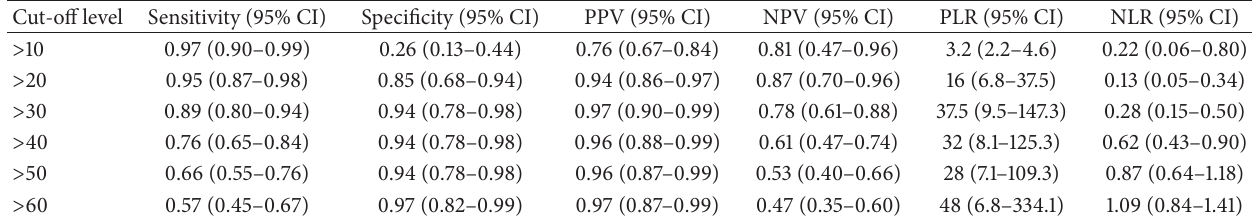
Table 3: Cut-off for cancer ratio (serum LDH: pleural ADA